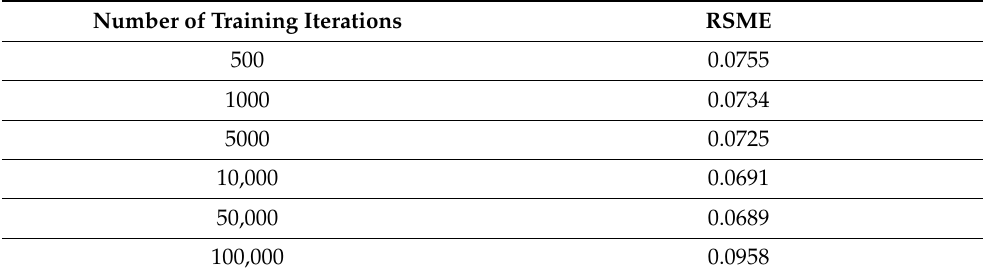
Table 20. Root mean squared error (RMSE) values based on the number of training sessions.